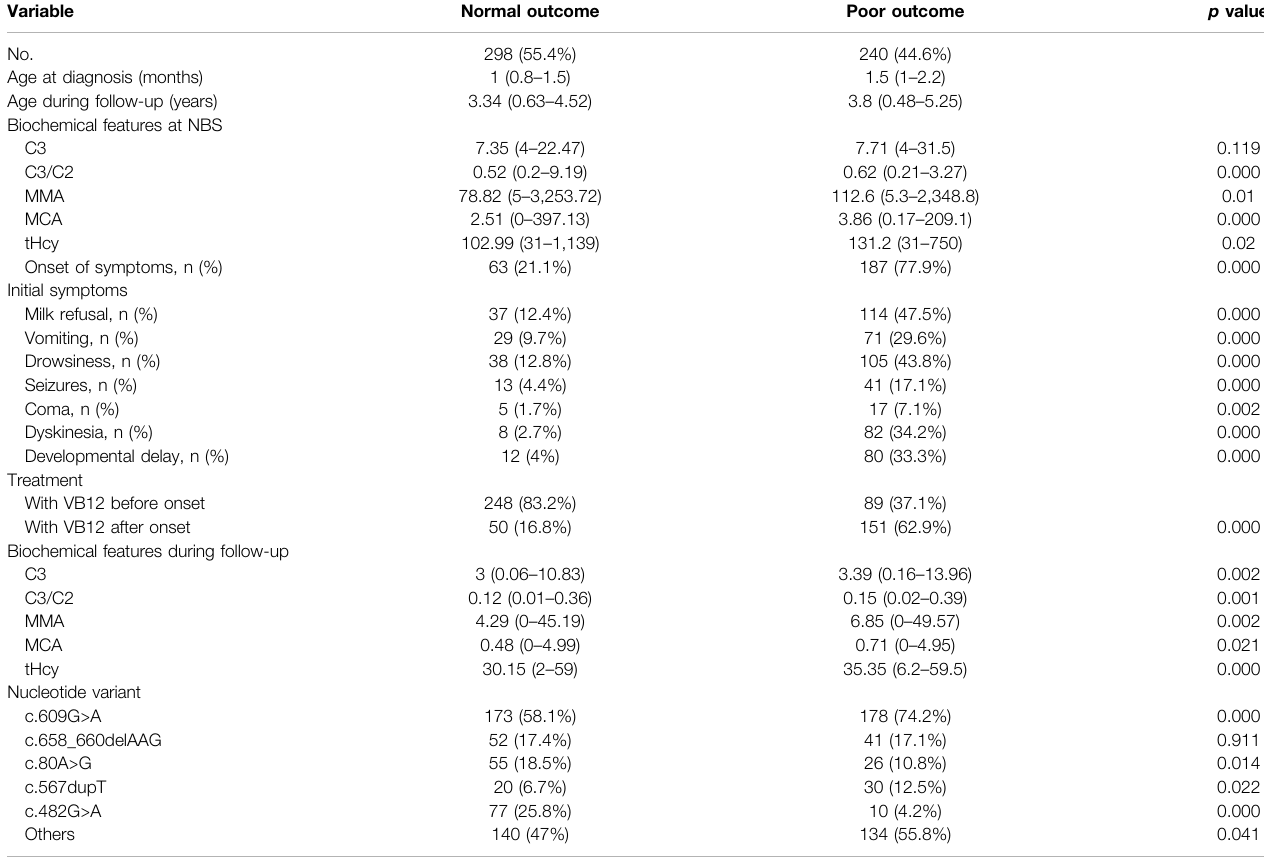
TABLE 1 | comparison of baseline demographic, clinical, and biochemical characteristics between patients with normal and poor outcomes.